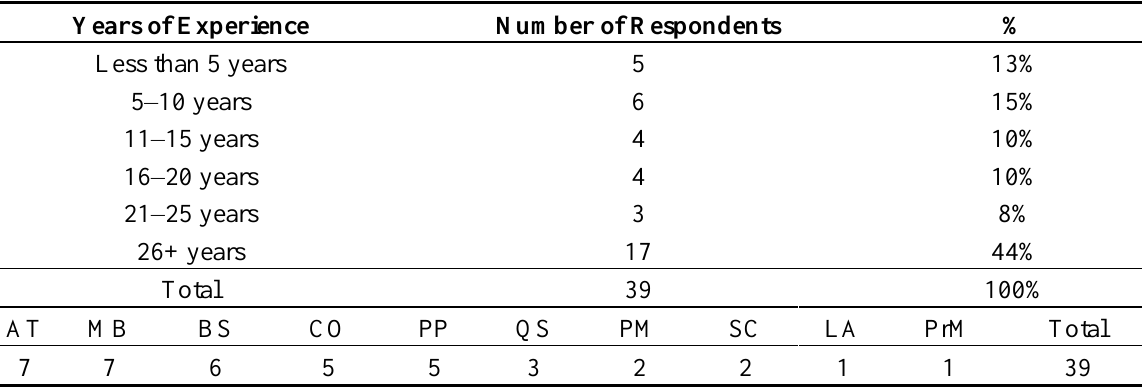
Table 4. Construction professionals’